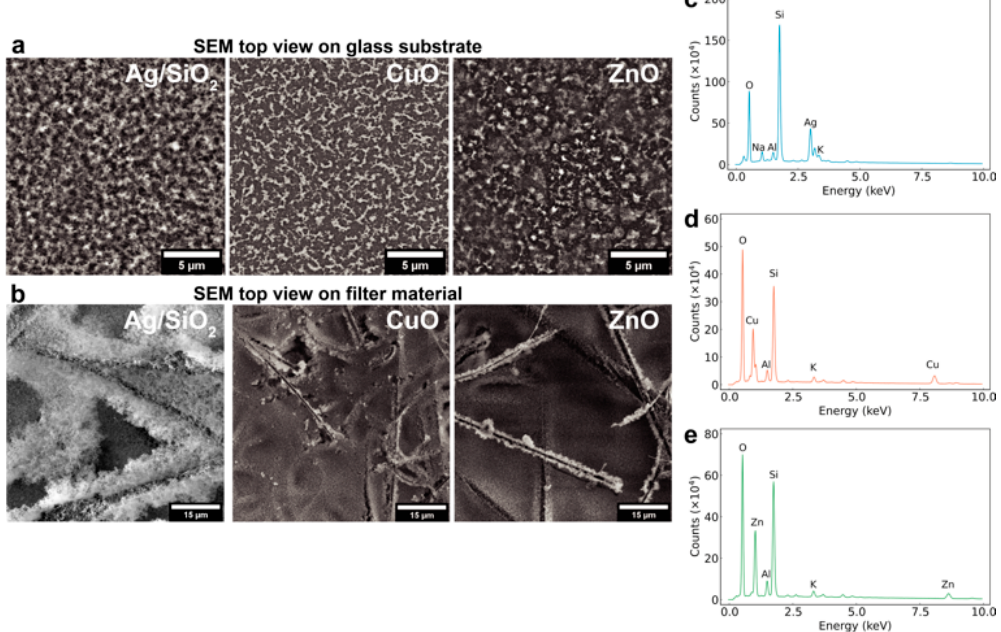
Figure 3. Scanning electron microscope images of all three Ag, CuO and ZnO nanocoatings on ( a ) flat glass substrates and ( b ) porous filter material along with their energy dispersive X-ray spectra in ( c – e ), respectively.